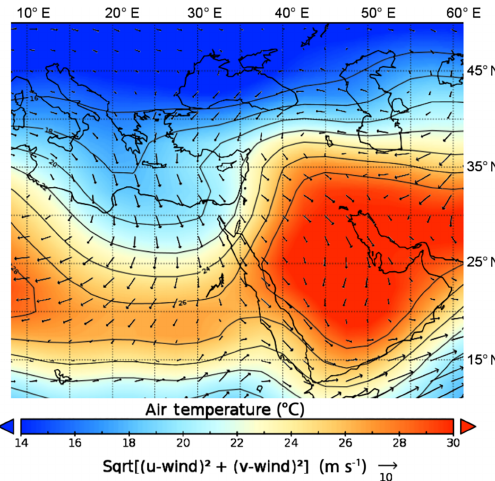
Figure 2. NCEP/NCAR reanalysis composite long-term mean tem- perature at 850hPa ( ∼ 1500ma . s . l . ) with wind vectors, averaged over 1948–2016, for July–August. Note the southward penetra- tion of the European cold air over the Mediterranean Basin. This cold air mass is transported at shallow tropospheric layers towards the eastern Mediterranean by the Etesian northwesterlies charac- terizing the Persian Trough. NCEP reanalysis data are provided by the NOAA/OAR/ESRL PSD, Boulder, Colorado, USA; http: